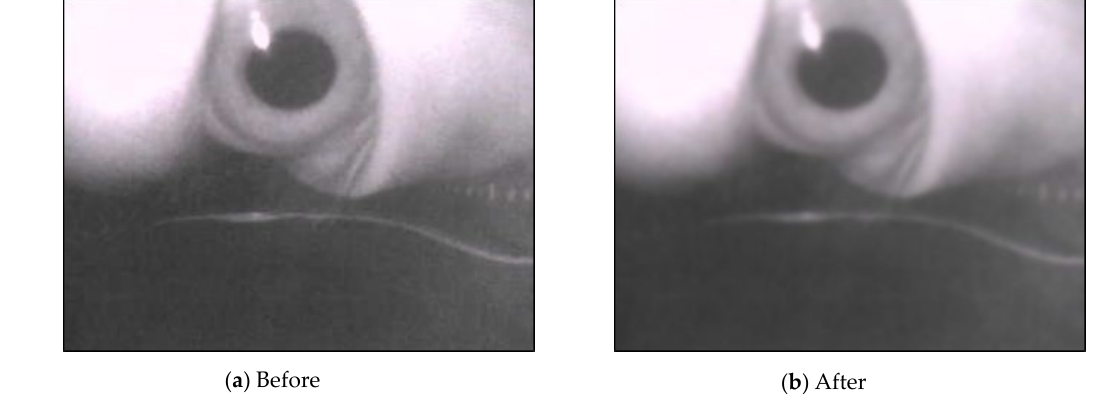
Figure 14. Results after using mean shift filtering.